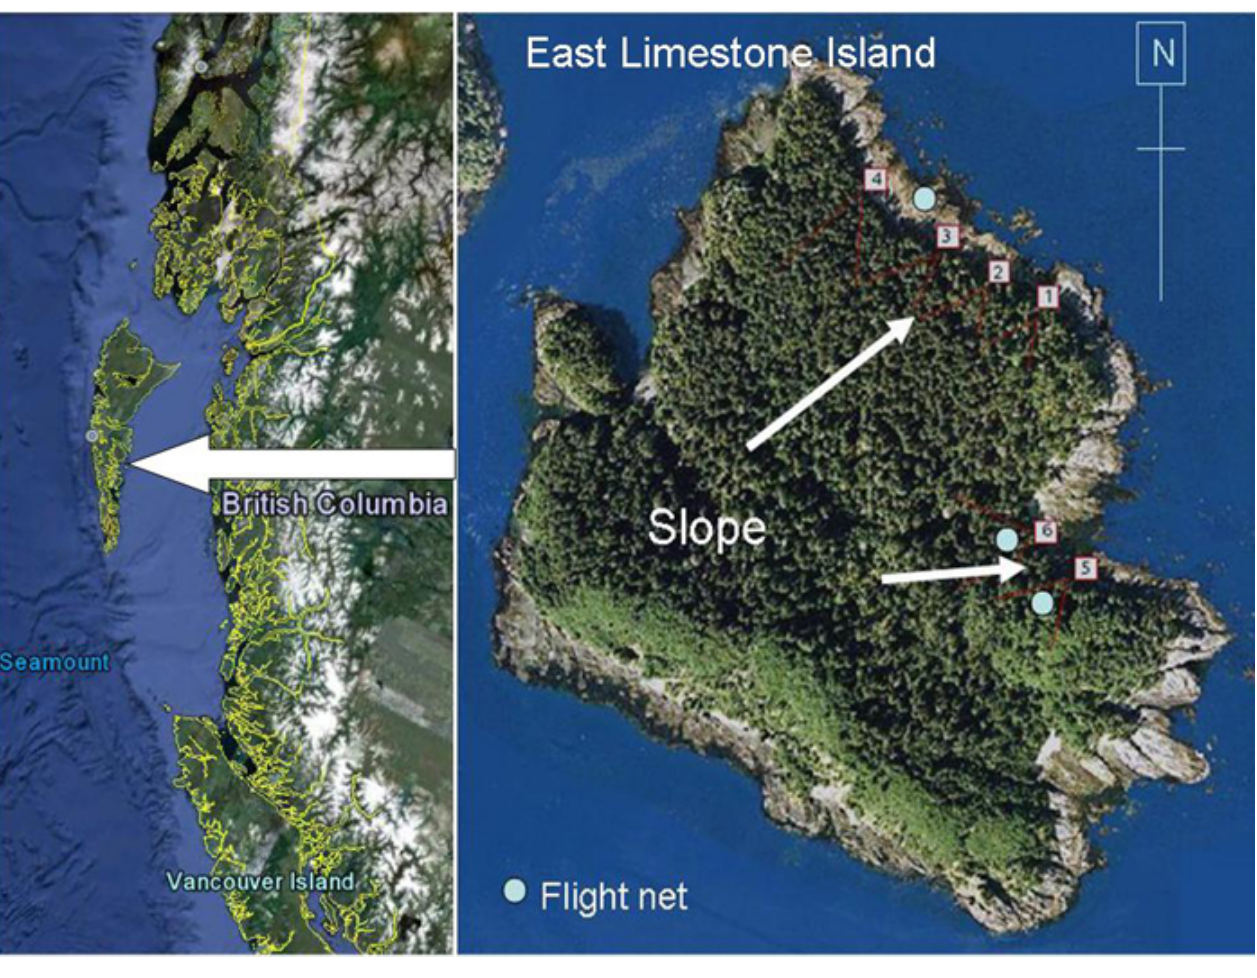
Fig. 1. Map showing the location of the study area and the position of chick-capture funnels (numbered) and flight nets on East Limestone